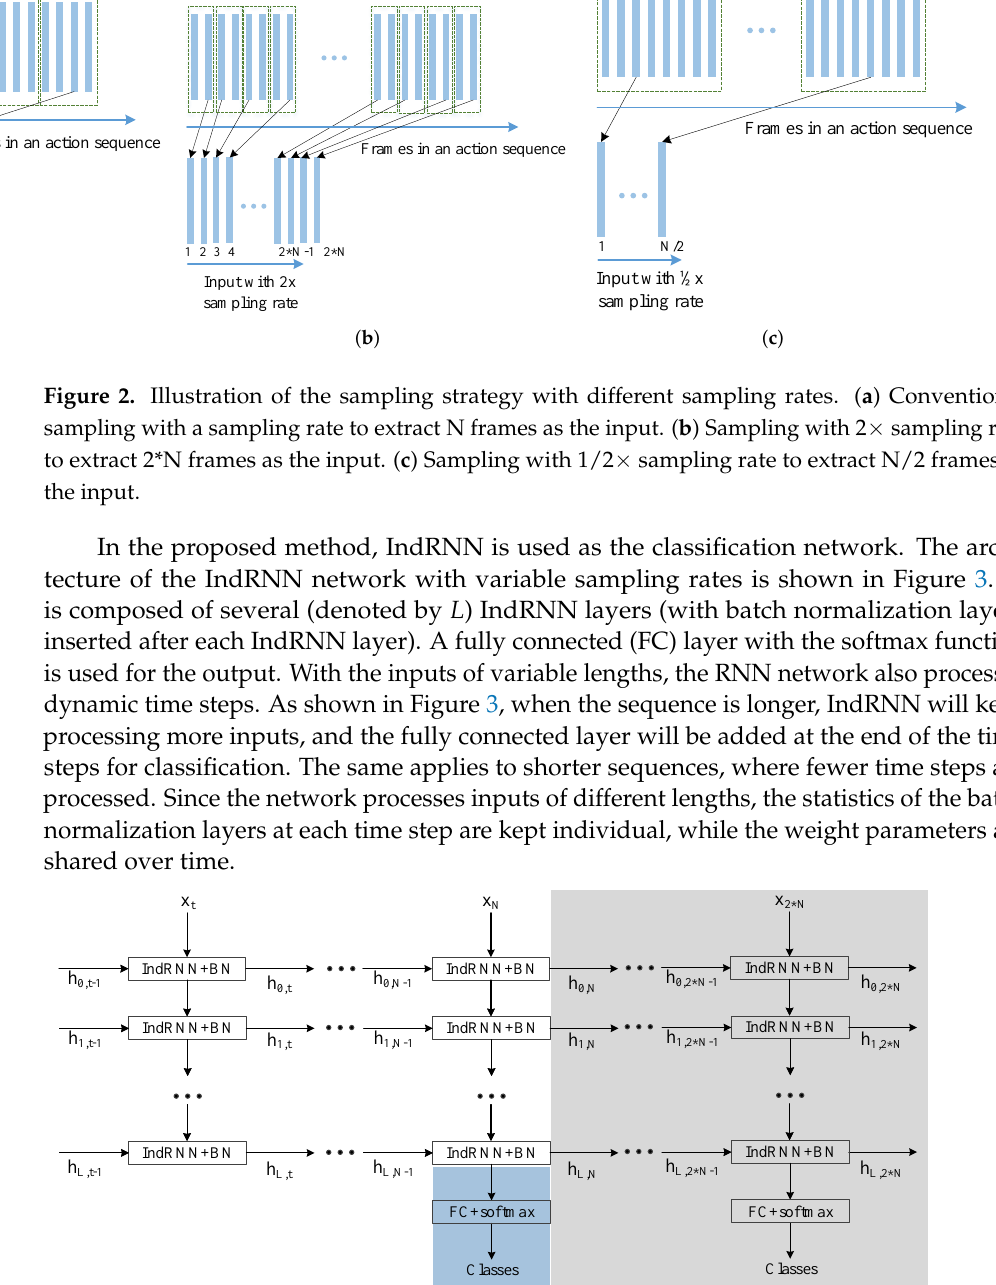
Figure 3. Architecture of the proposed variable rate